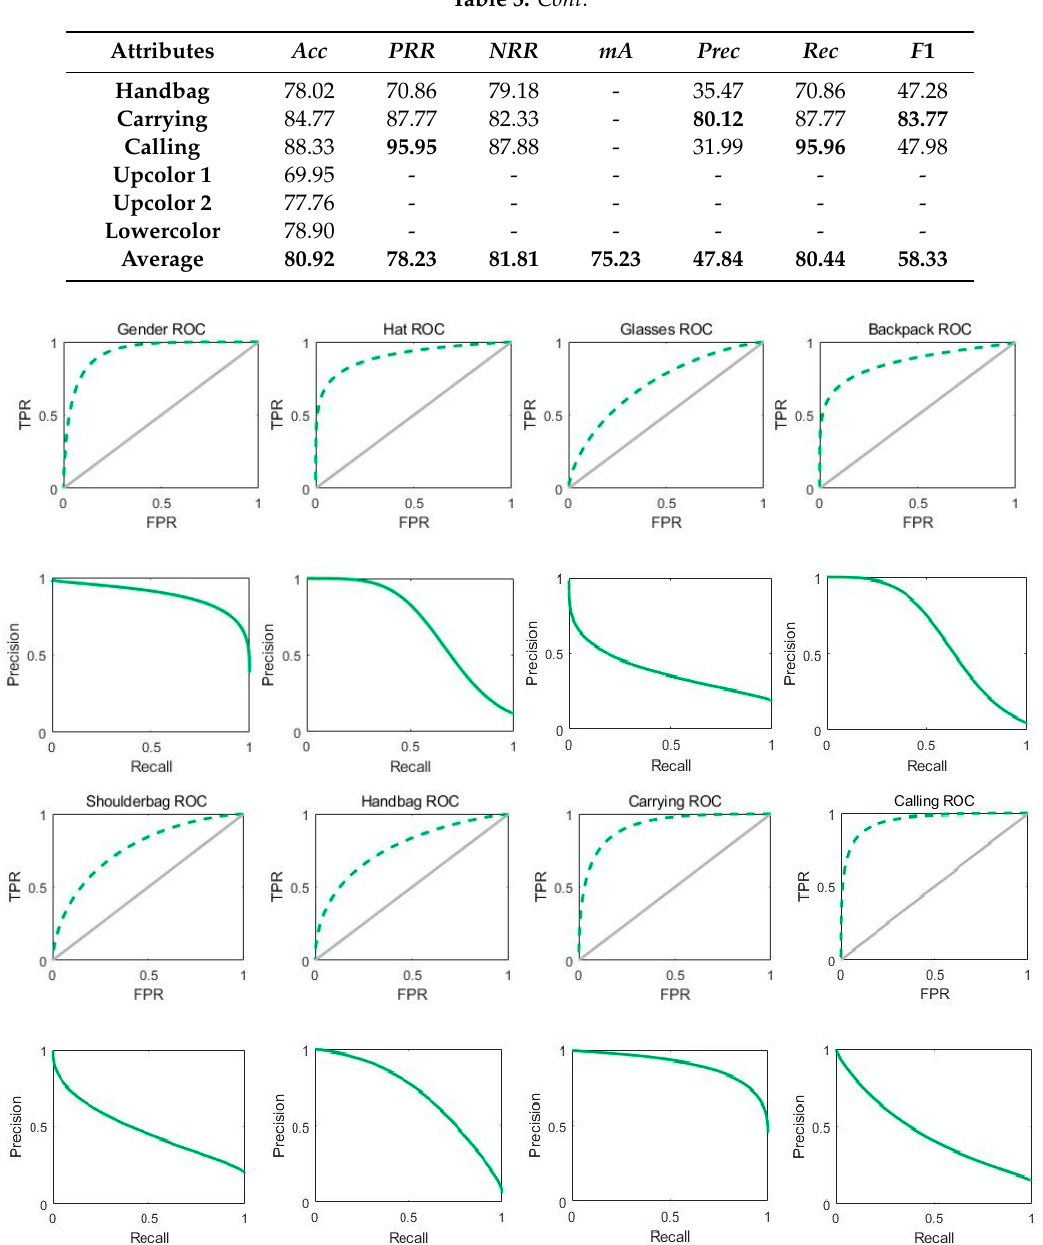
Figure 4. Di ff erent attributes’ ROC and PR curves on NEU-dataset. The first and third rows are ROC curves, and the second and fourth rows are the corresponding PR